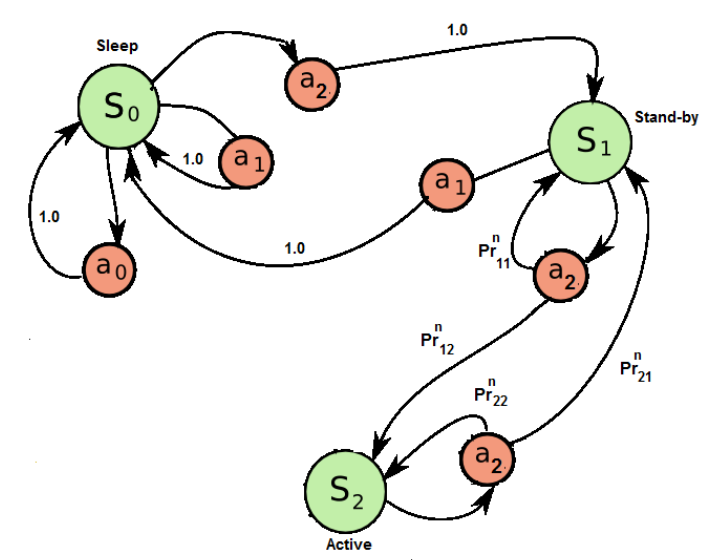
Figure 4. Proposed Three-state Markov Model for n th base station where 2 ≤ n ≤ N . (note: The 1 st BS is always